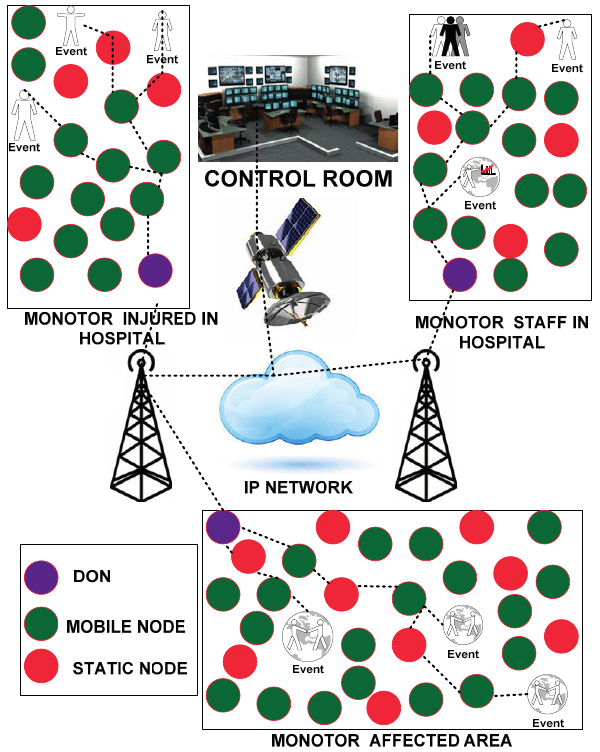
Figure 1. Deployment of a WSN for monitoring the disaster recovery